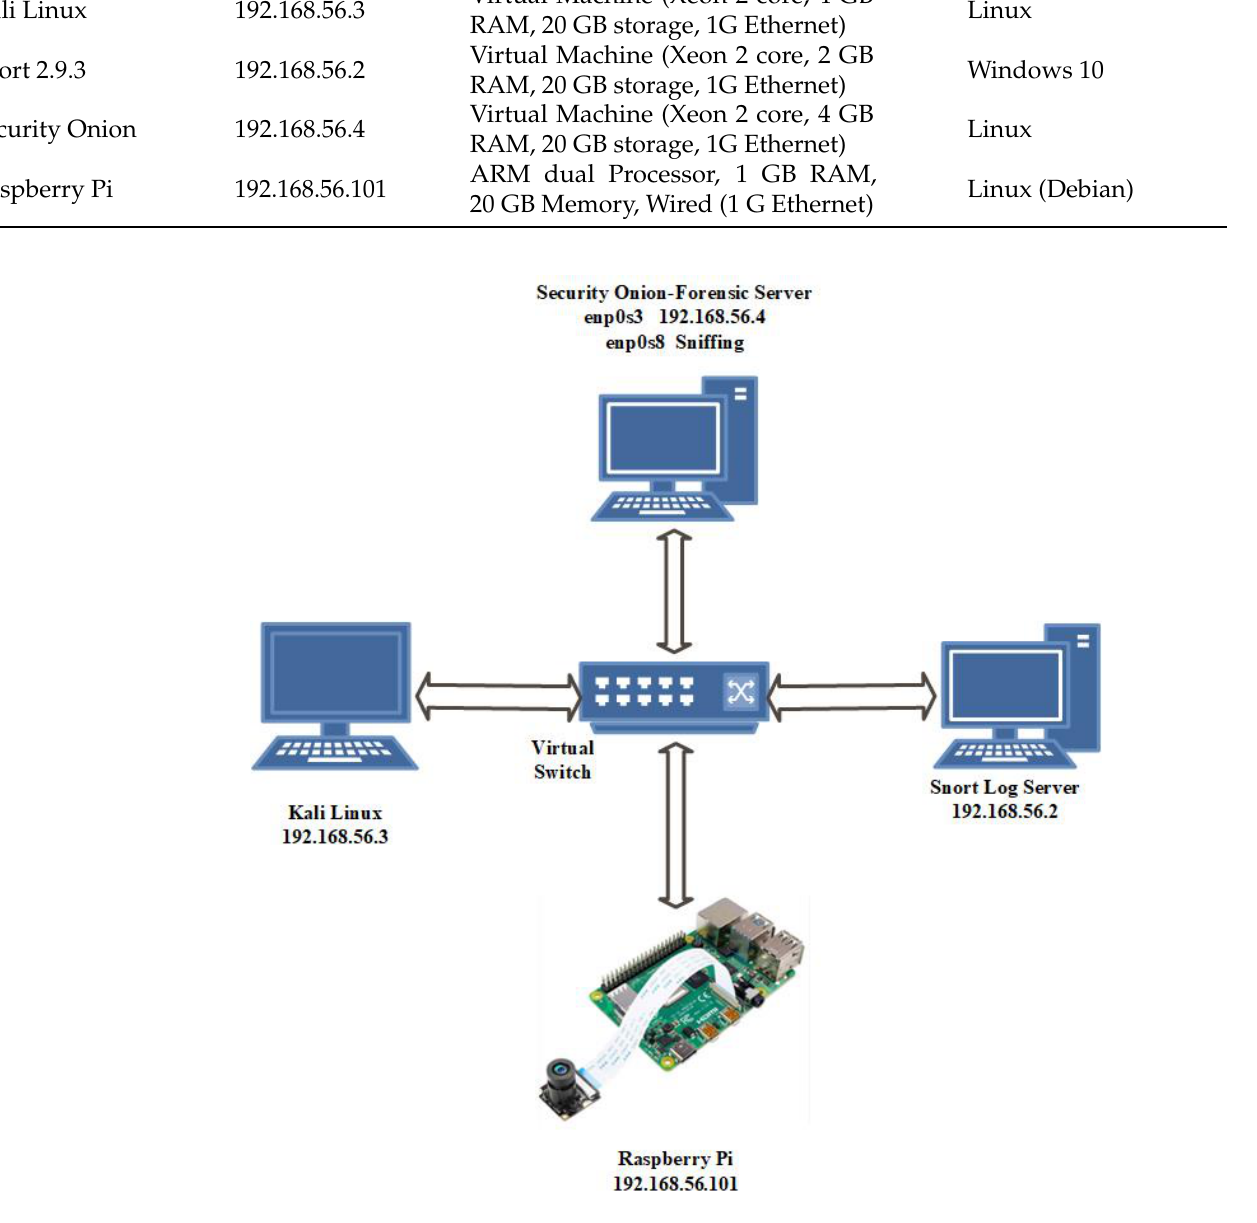
Figure 3. Network diagram of the proposed